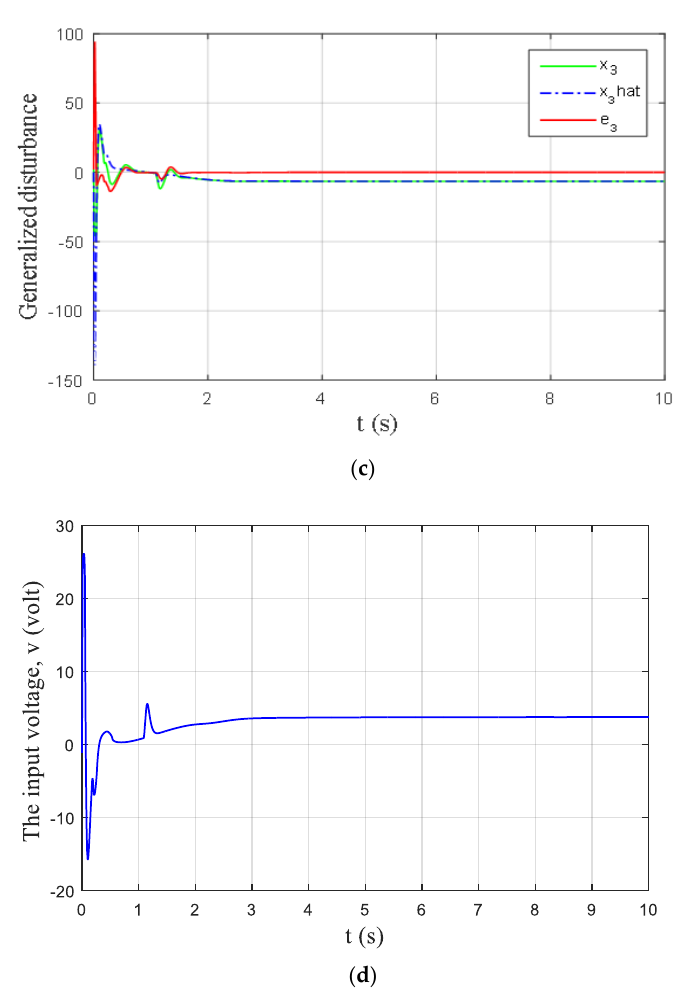
Figure 3. Results of the numerical simulations of the PMDC motor by EADRC-linear extended state observer (LESO). observer